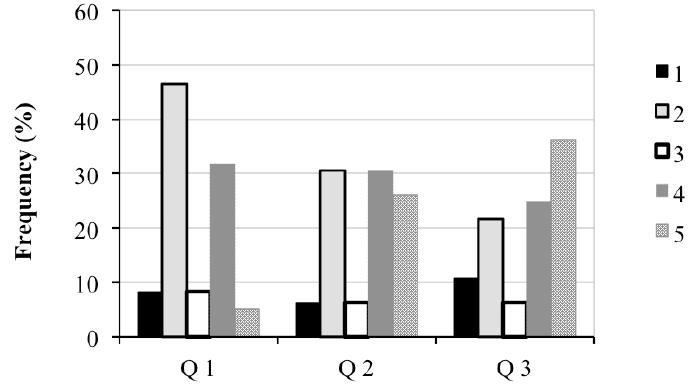
Fig. 5. Students’ responses to the questions of Questionnaire B presented on a five-point Likert scale, where 1 is the least